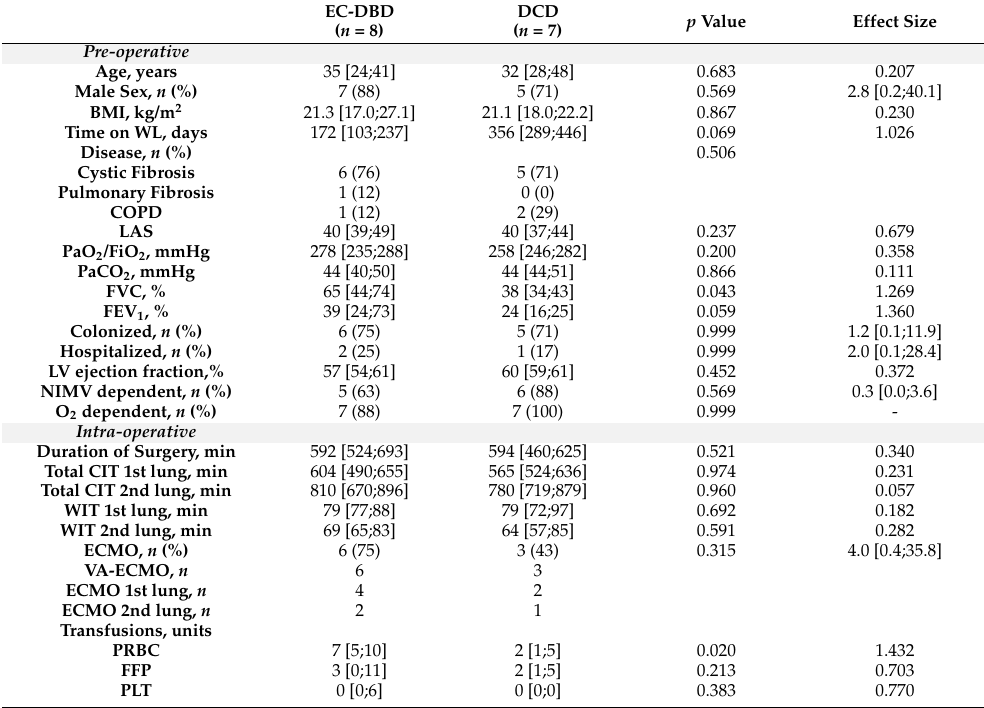
Table 4. Recipient